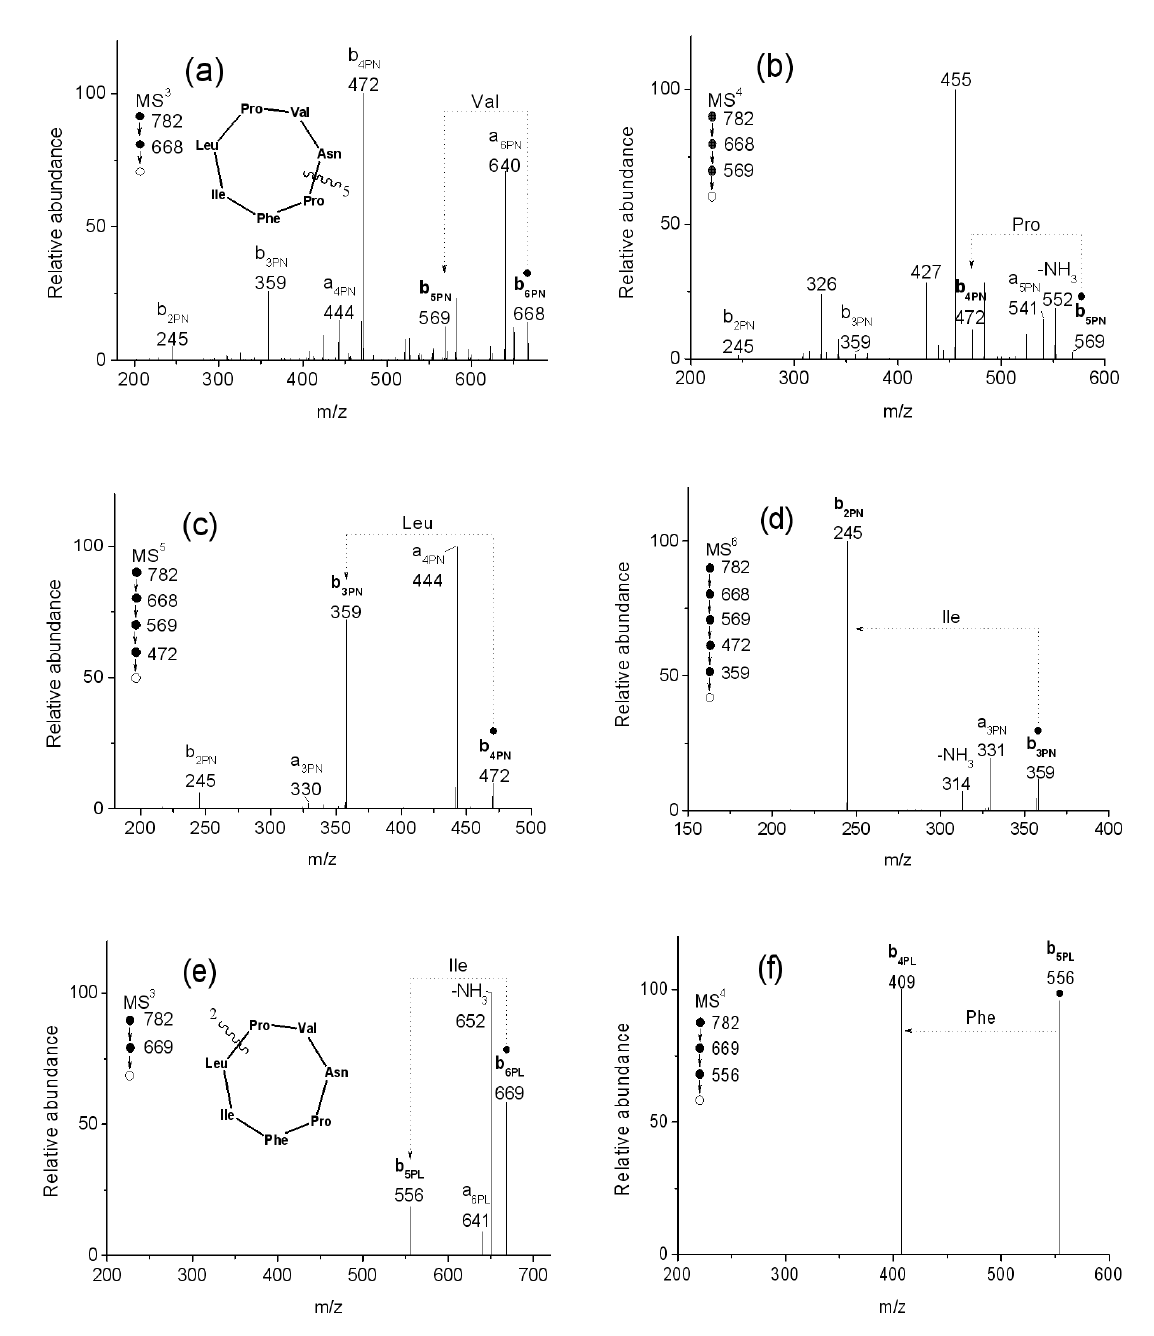
Fig. 3 Product-ion spectra generated by multiple stages of MS/MS. (a-d) MS n spectra of the b , Pro-Phe-Ile-Leu-Pro-Val + ; (e-h) MS n spectra of the b 6 PN Phe-Ile + . The simple schemes of the ring-opening pathways to form the b are shown in panel (a) and (e), respectively. In the two sets of mass spectra, the amino acid residues are sequentially eliminated from C-termini one at each stage of MS/MS. The parent ions are marked with “ •